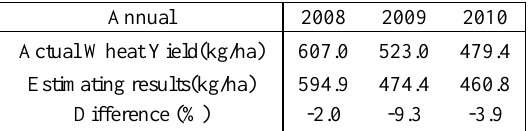
Table 3. The results of wheat yield estimating in 2008-2010a phenomenon. The temperature in Feb. 2009 is higher than normal years; especially in the middle 10-days of Feb. the average temperature was double higher than normal years. The wheat re-greening date was much earlier, and NDVI value was too higher. The retrieval results showed that the value of ∑NDVI from re-greening to maturity in 2009 is 0.4 larger than 2008a, and 0.7 larger than 2010a. The larger ∑NDVI value lead to the AGB retrieved value was slightly larger accordingly.